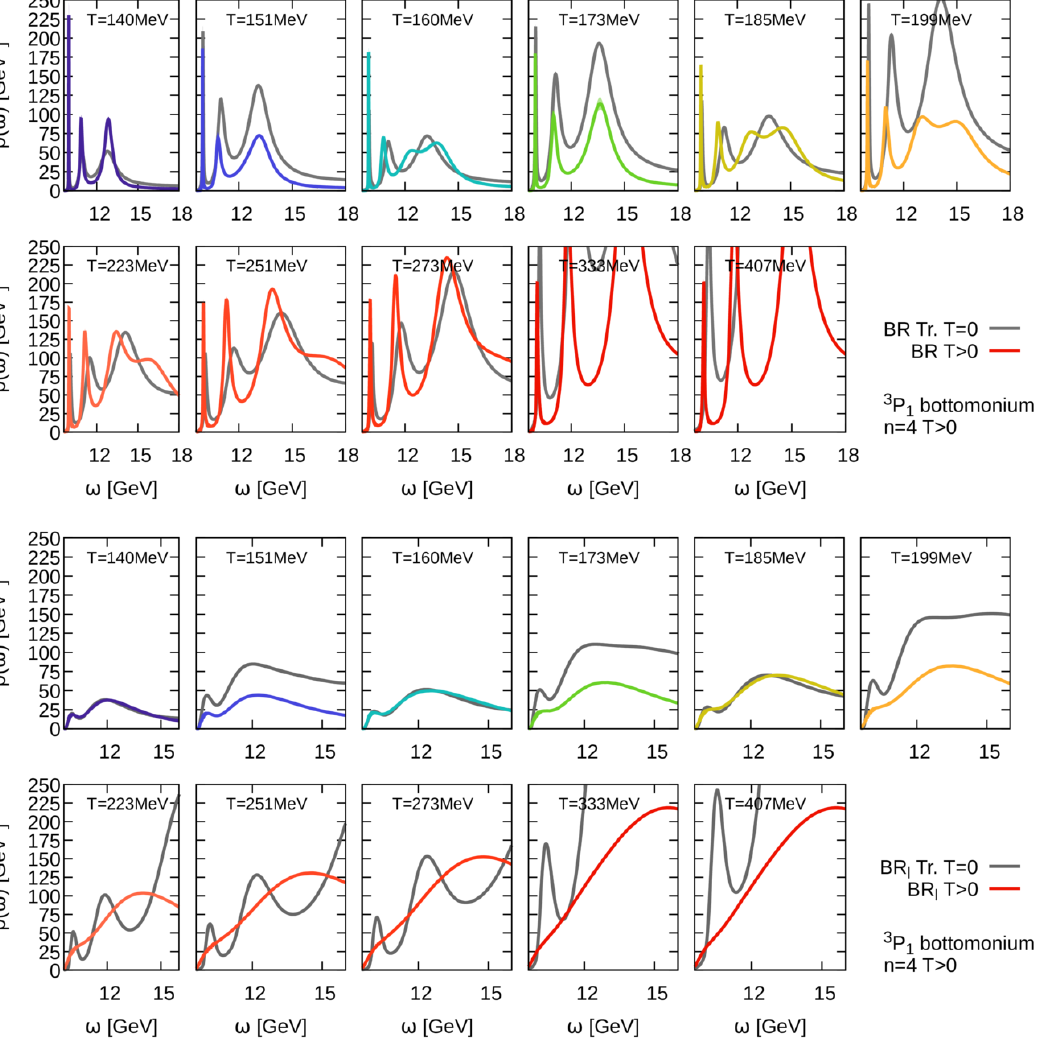
Figure 41 . Comparison of the (top) BR truncated at T = 0 and at T > 0 (bottom) the same comparison for the smooth BR method in the 3 P 1 bottomonium channel. Note the di(cid:11)erence in statistics available between T = 0 and T > 0 here. For Charmonium the statistics in the two cases are the